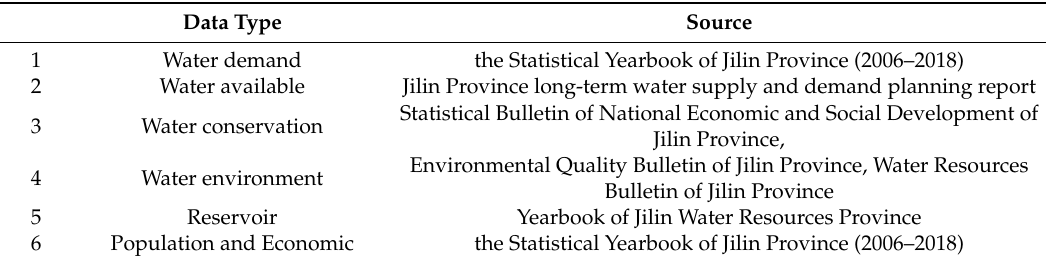
Table 1. Data used in the study and their sources.